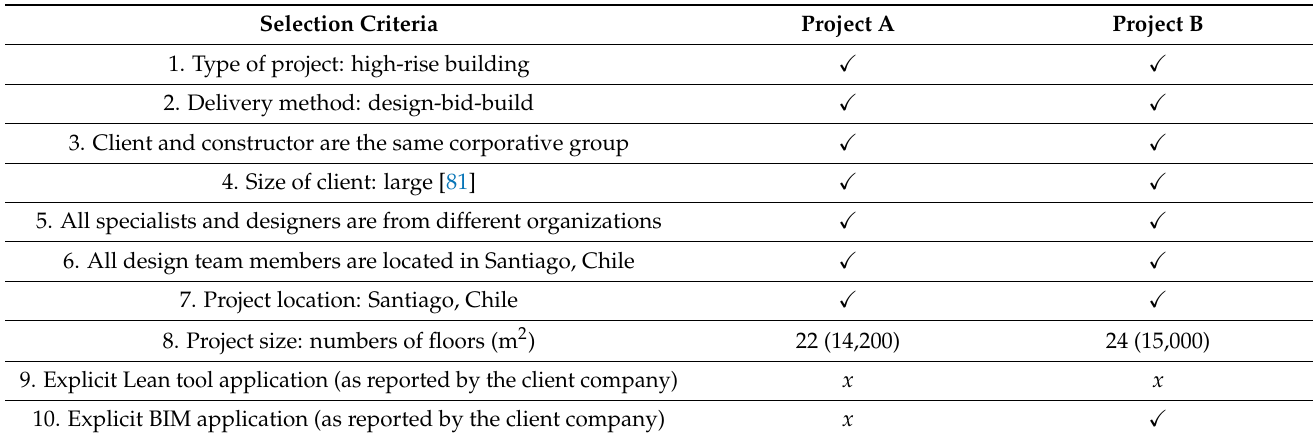
Table 4. Characteristics of projects A and B according to the selection criteria. Selection